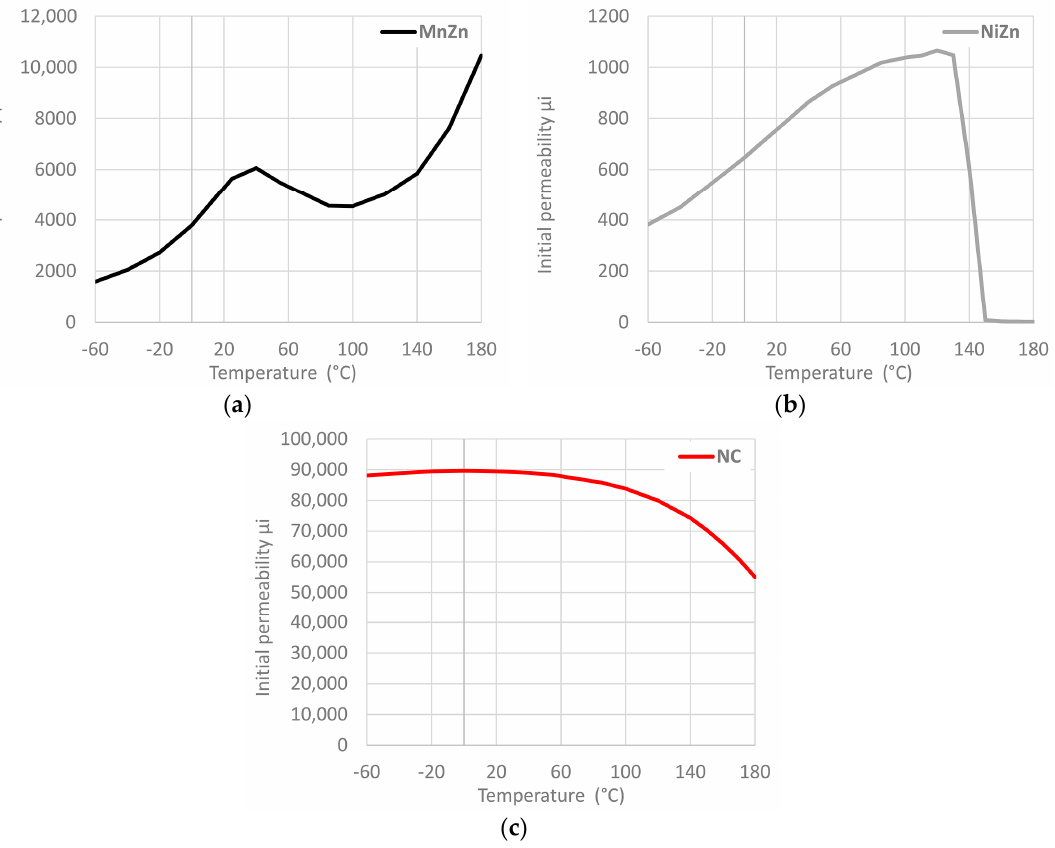
Figure 4. Initial permeability versus temperature for three different cable ferrites: ( a ) MnZn; ( b ) NiZn; ( c ) NC.